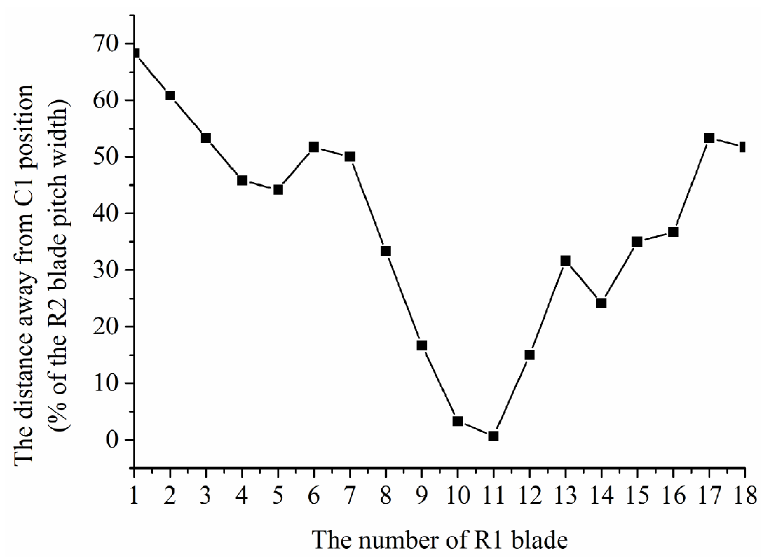
Figure 18. The relative clocking positions between the R1 and R2 blades (referred to as the C1 clocking position); experimental results.